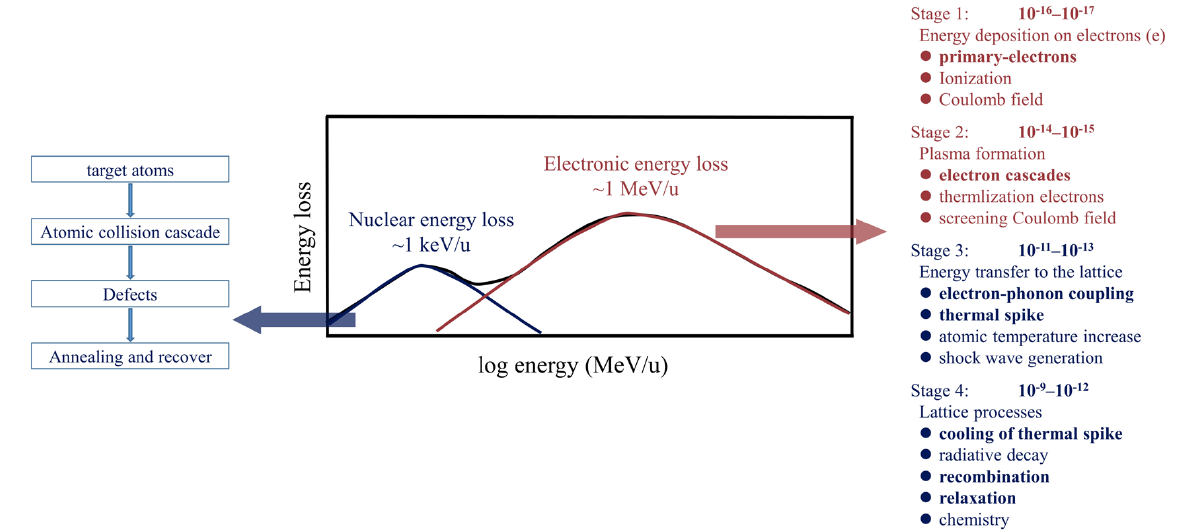
Figure 4. Schematic diagram of the relationship between energy loss and bombarding particle energy.